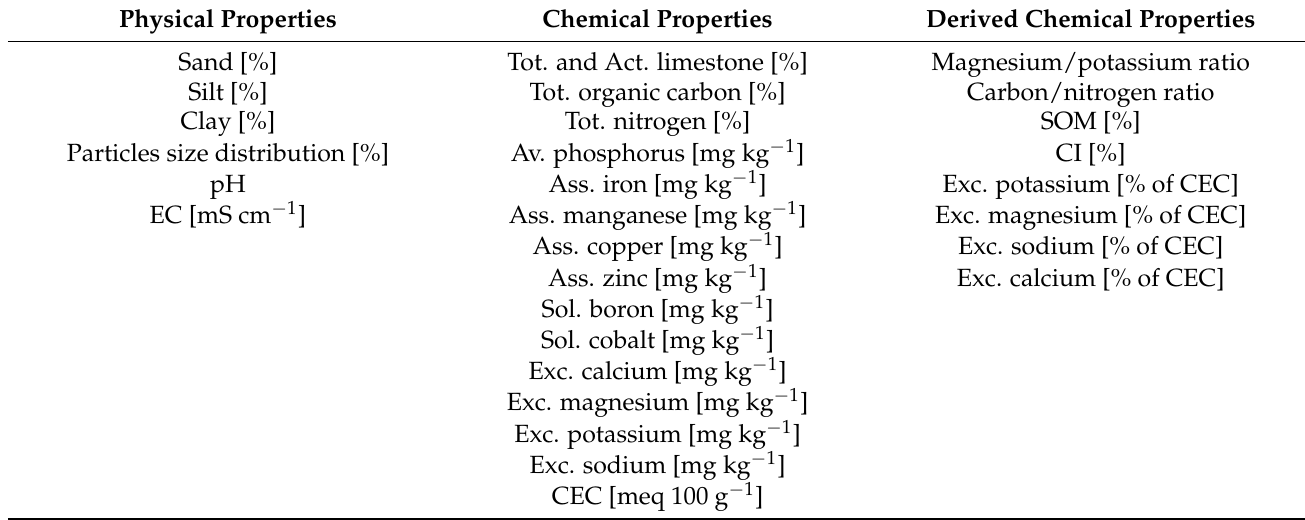
Table 1. Soil analyses and associated units of measure carried out on the 20 sampling set points. Percentages are mass over mass (m/m). Abbreviations: Tot., Total; Act., Active; Av., Available; Ass., Assimilable; Sol., soluble; Exc., exchangeable; CEC, Cation Exchange Capacity; EC, Electrical Conductivity; CI, Colloids Index; SOM, Soil Organic